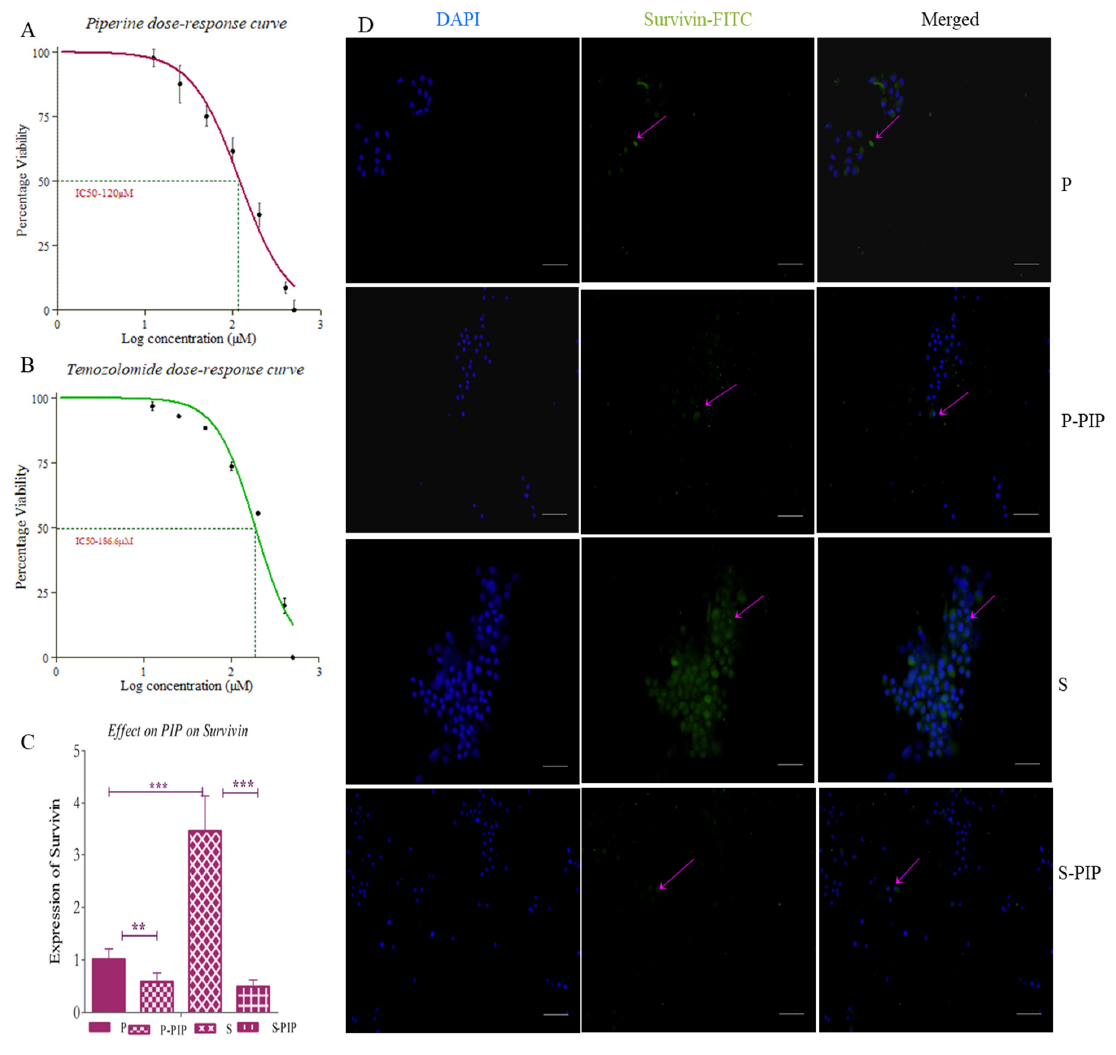
Figure 11. Inhibitory effect PIP on survivin: ( A ) dose − response curve of PIP and ( B ) TMZ on U87 cells. ( C ) The inhibition of survivin by PIP. Expression of survivin in control and treated cells studied using RT ‐ PCR. ( D ) Immunostaining images of survivin on both P and S cells with and without PIP treatment, stained using FITC and counterstained with DAPI. The graphical data are presented as mean ± SD, and the statistical analysis was performed using one ‐ way ANOVA ( **: p ‐ value < 0.01; ***: p ‐ value < 0.001). The scale bar indicates 20 μ m.